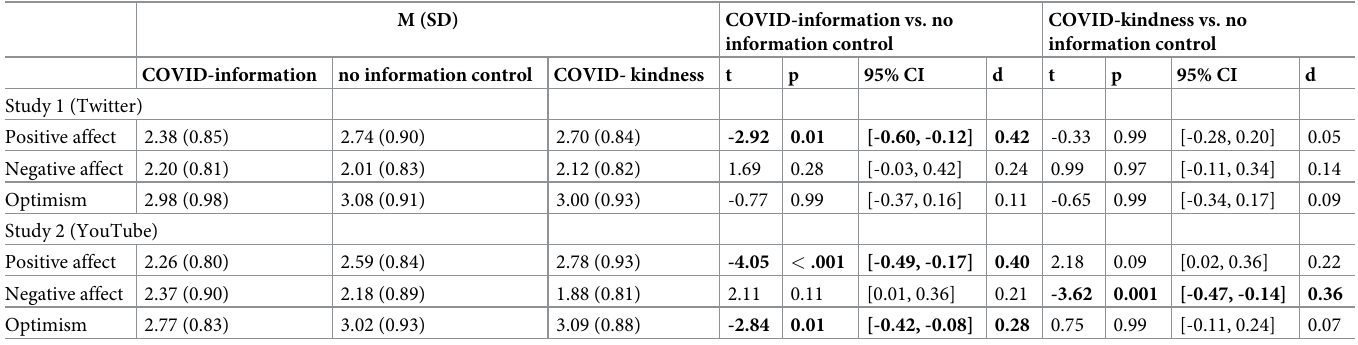
Table 1. Pairwise comparisons between the no information control condition and each of the other conditions in Studies 1 (Twitter) and 2 (YouTube). M (SD)